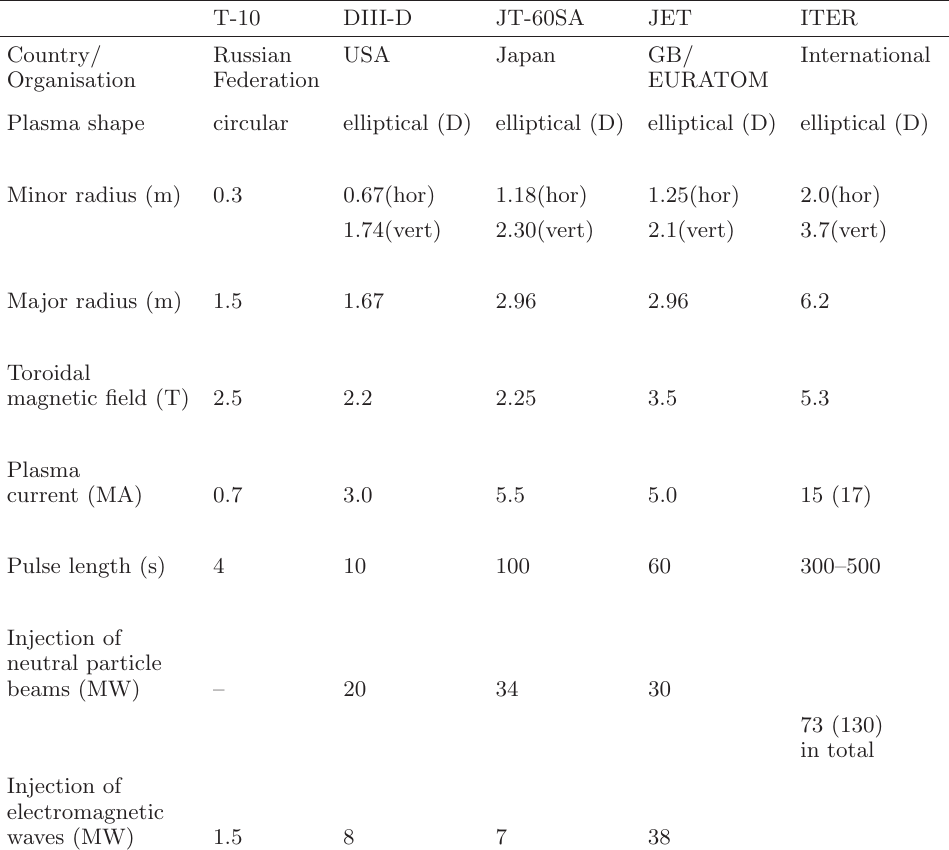
Table III. – Main parameters of important